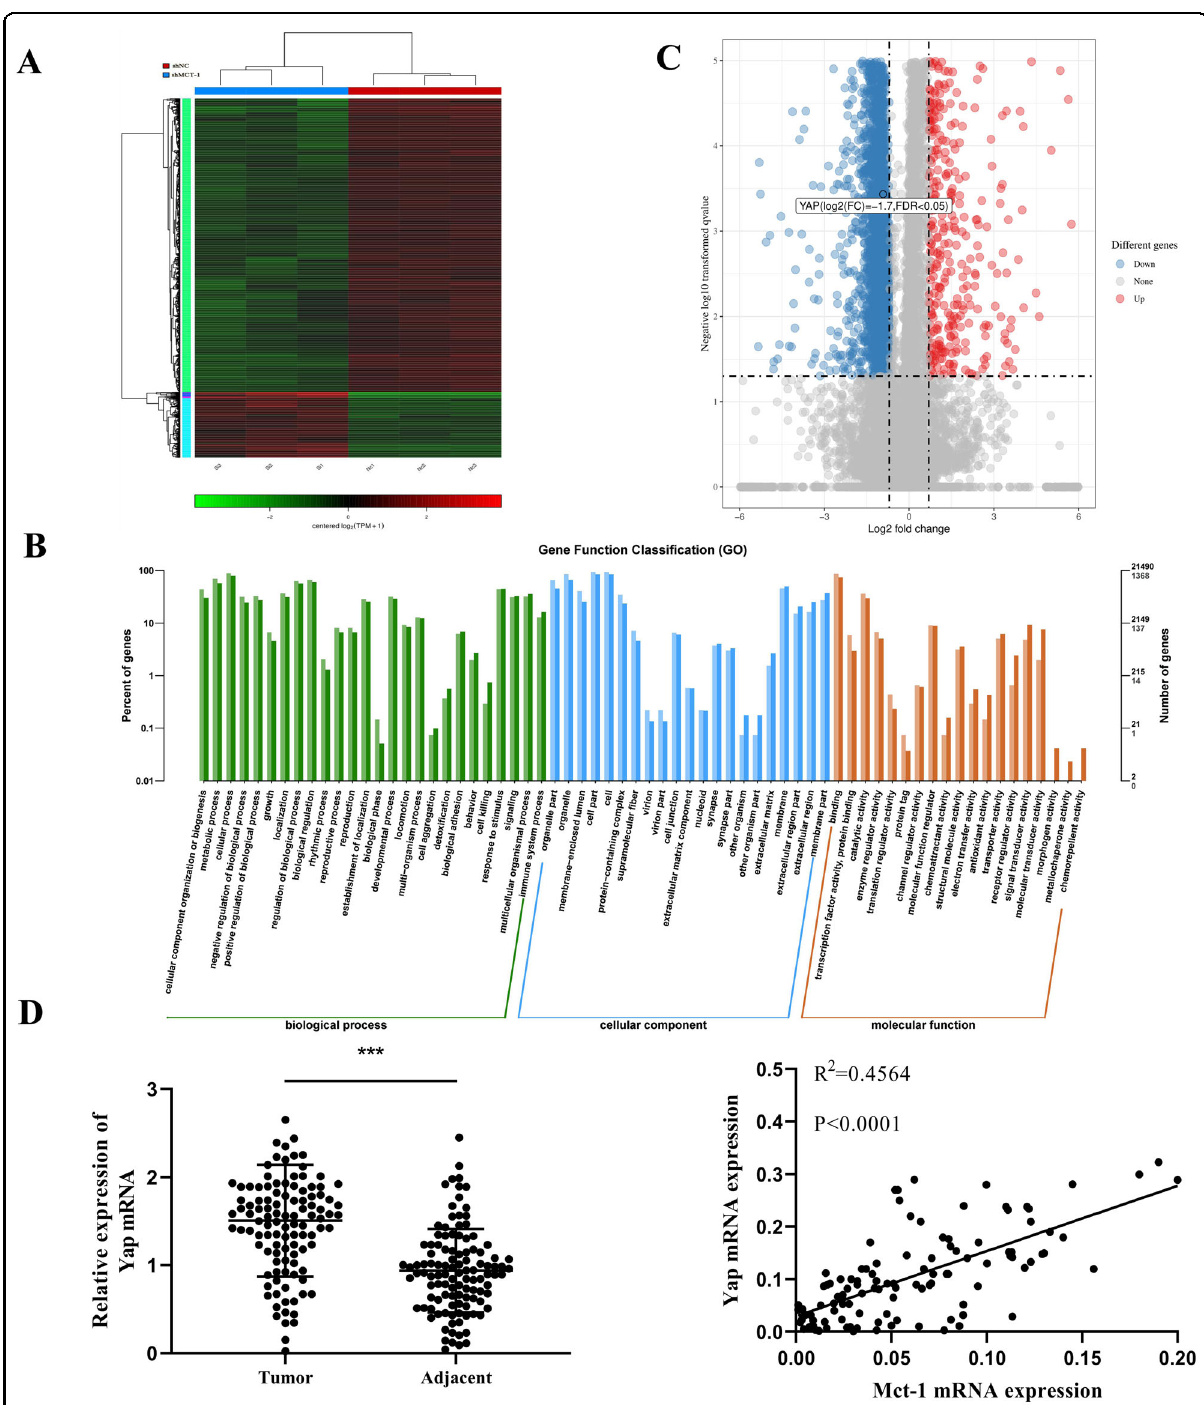
Fig. 5 Yap expression is closely related to Mct-1 expression in vitro. A A heatmap of DEGs in the Mct-1 silenced (shMct-1) and negative control (shNC) groups. DEGs with a log 2 fold change (FC) > 1 are indicated in red, while those with a log 2 FC < 1 are indicated in green. B Gene function classi fi cation analysis of the shMct-1 and shNC groups of MHCC97H cells. C A volcano plot of DEGs in the shMct-1 and shNC groups of MHCC97H cells. DEGs with a log 2 FC > 1 are indicated in red, while those with a log 2 FC < 1 are indicated in blue. D qRT-PCR was used to examine the expression of Yap in 112 pairs of HCC tissues and corresponding peritumor tissues. E The expression patterns of Mct-1 and Yap were positively correlated in HCC specimens. The data are presented as the mean ± SD of experiments performed in triplicate. * p < 0.05, ** p < 0.01, *** p < 0.001.